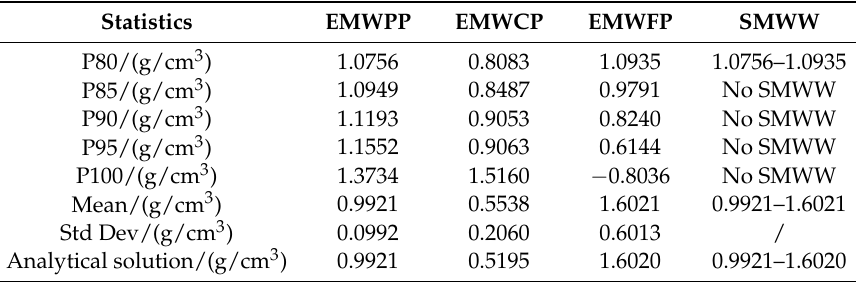
Figure 21. Cumulative probability of SMWW. Table 4. The statistics for EMWPP, EMWCP, EMWFP and SMWW.